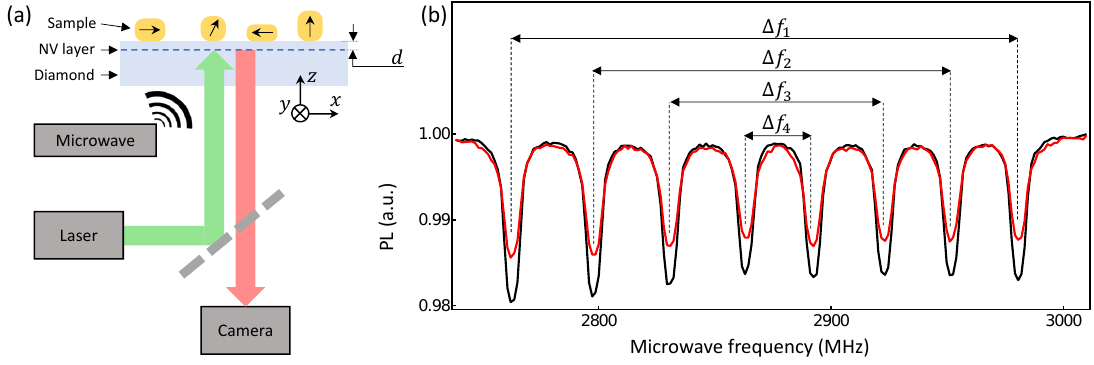
Figure 1. ( a ) Schematic of the experimental setup. The sensing platform consists of a diamond substrate hosting a layer of near-surface nitrogen-vacancy (NV) centres. The magnetic samples to be imaged (here magnetic nanoparticles shown as yellow objects; the arrows depict their magnetisation) are placed directly on the diamond surface. The NV photoluminescence (PL) under green laser and microwave excitations is imaged on a camera to form the magnetic field image of the sample via optically detected magnetic resonance (ODMR). ( b ) Example ODMR spectra obtained from a single imaging pixel 500 × 500 nm 2 in size. Measurement of the four Zeeman splittings ∆ f i ( i = 1 . . . 4) allows reconstruction of the local vector magnetic field. The two spectra correspond to two different locations on the sample, namely near (red) and laterally far from (black) a magnetic particle (see details in text and Figure